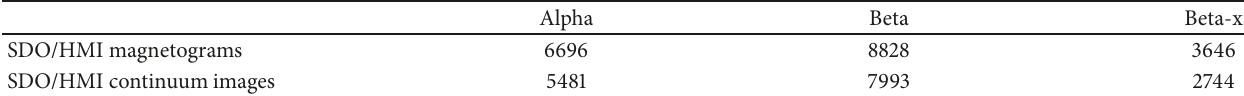
Table 2: Distribution of magnetic types of SDO/HMI magnetograms and continuum